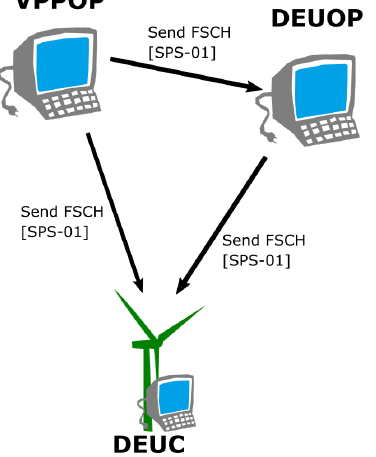
Figure 11. Actors–Transactions Diagram: Meta-Actors connected by the functions to be specified in Volume Two for